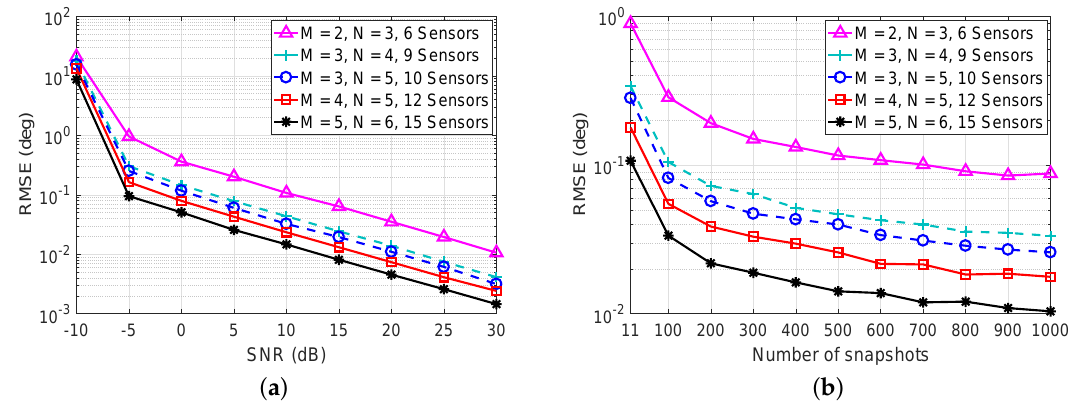
Figure 9. RMSE performance of the proposed algorithm with different numbers of sensors in the coprime array. ( a ) RMSE versus the SNR with L = 50; ( b ) RMSE versus the number of snapshots with SNR = 0